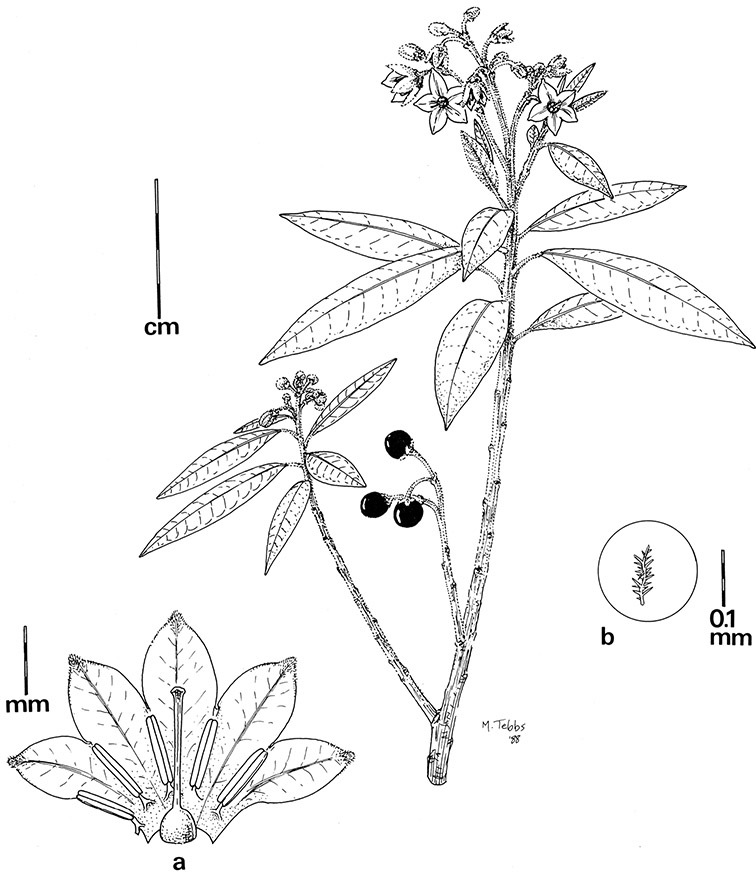
Solanum stenophyllum Dunal. (A–B drawn from Pennell 3082). Reproduced from Knapp (1989) with permission of the Natural History Museum Botany Library. Illustration by Margaret Tebbs.